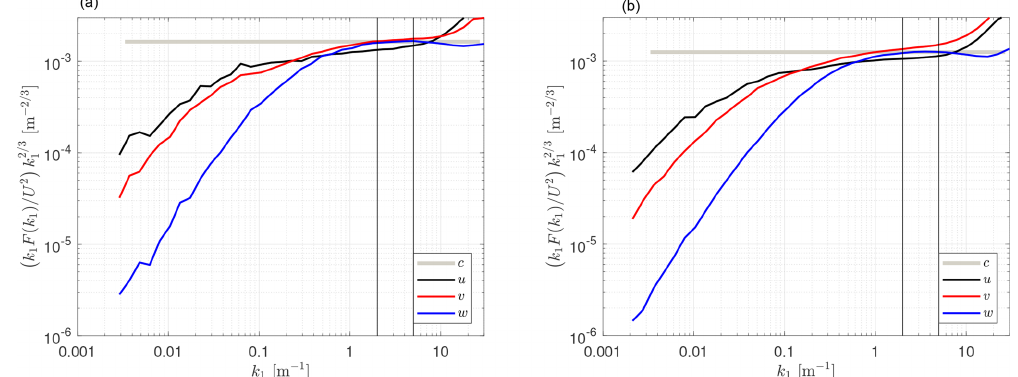
Figure 6. Similar to Fig. 3, but for the CSAT3 at the Risø test site. For the direction parallel to the boom (a) , the average spectra were computed over 72 different 10min samples, whereas for the directions perpendicular to the boom (b) , the average was based on 453 different 10min samples.